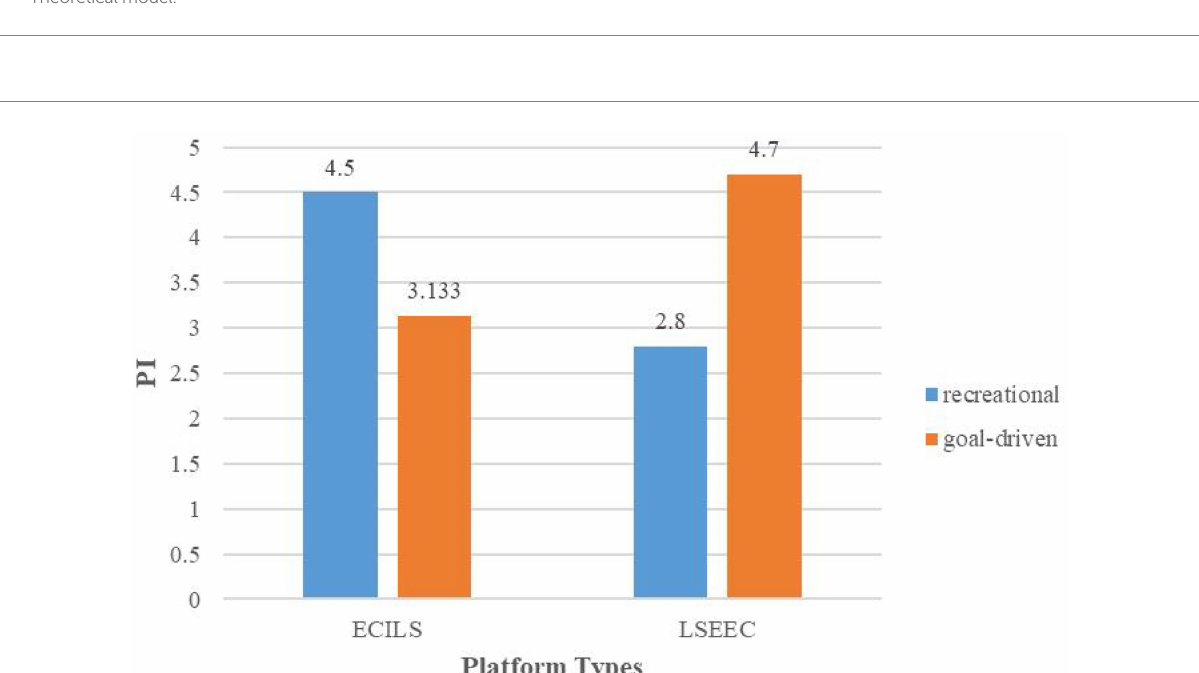
FIGURE 2 The impact of the interaction between platform types and consumer types on purchase intention.